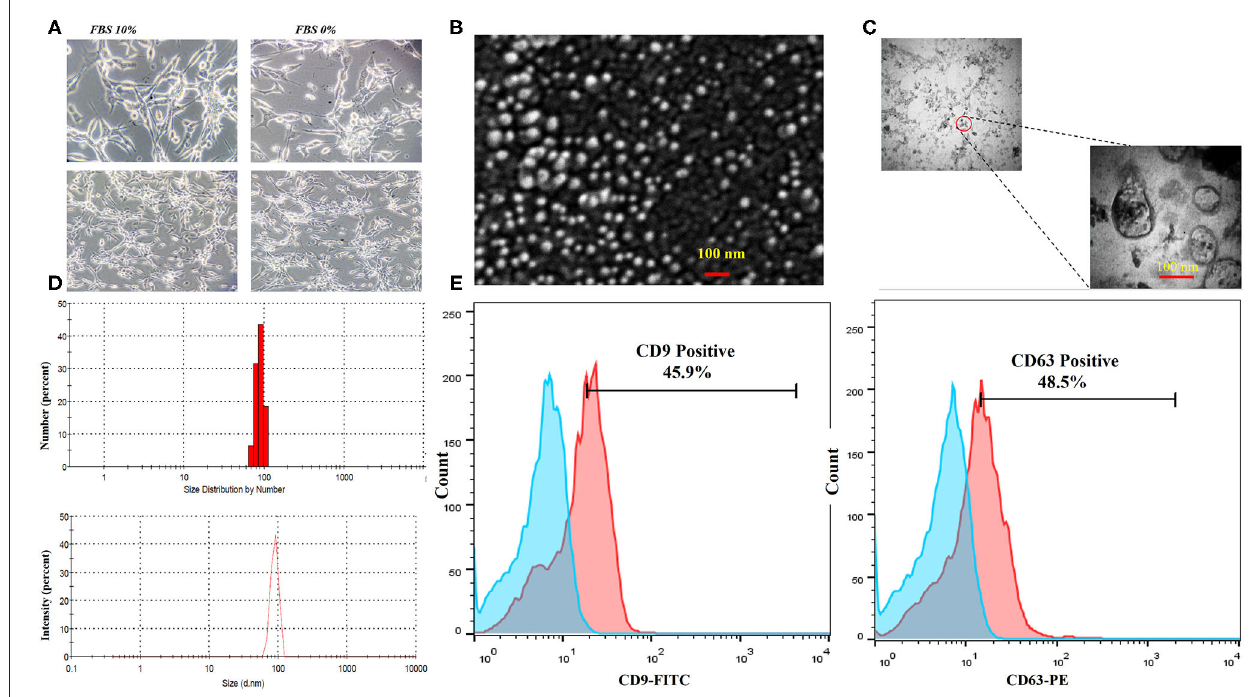
FIGURE 2 | Characterization of CT-26 cell line-derived exosomes. (A) Morphology of CT-26 cells in two different conditions, FBS 10% and FBS 0%; in the FBS-free condition under a light microscope. No significant morphology changes were detected. (B) Scanning electron microscopic image of CT-26-derived TEXs. (C) Transmission electron microscopic image of CT-26-derived TEXs. (D) Size distribution of CT-26-derived TEXs by number and intensity using dynamic light scattering. (E) Flow cytometry analysis revealed that isolated exosomes were positive for CD9 and CD63 exosomal markers. TEX, tumor exosome.